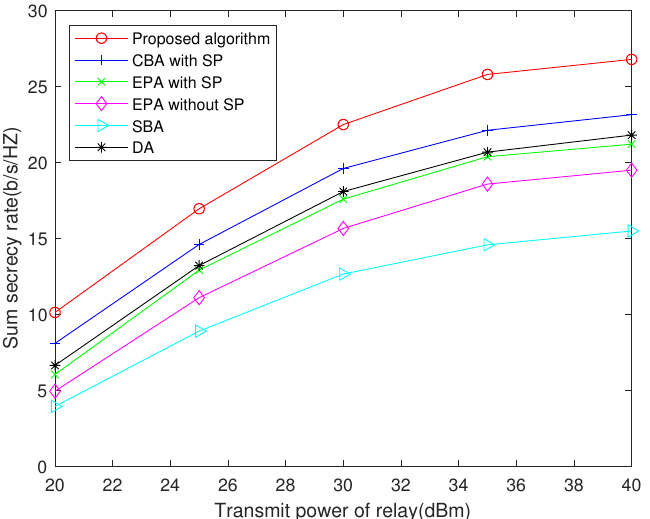
Figure 7. Sum secrecy rate versus transmit power of relay R when N = 16 and transmit power of user nodes is 20